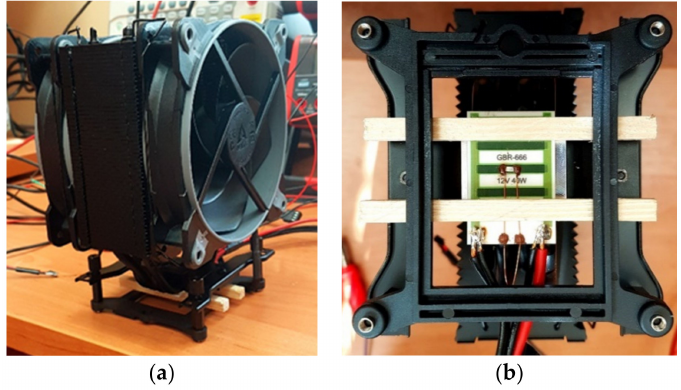
Figure 5. View of cooling configuration C—general ( a ) and from the heat source side ( b